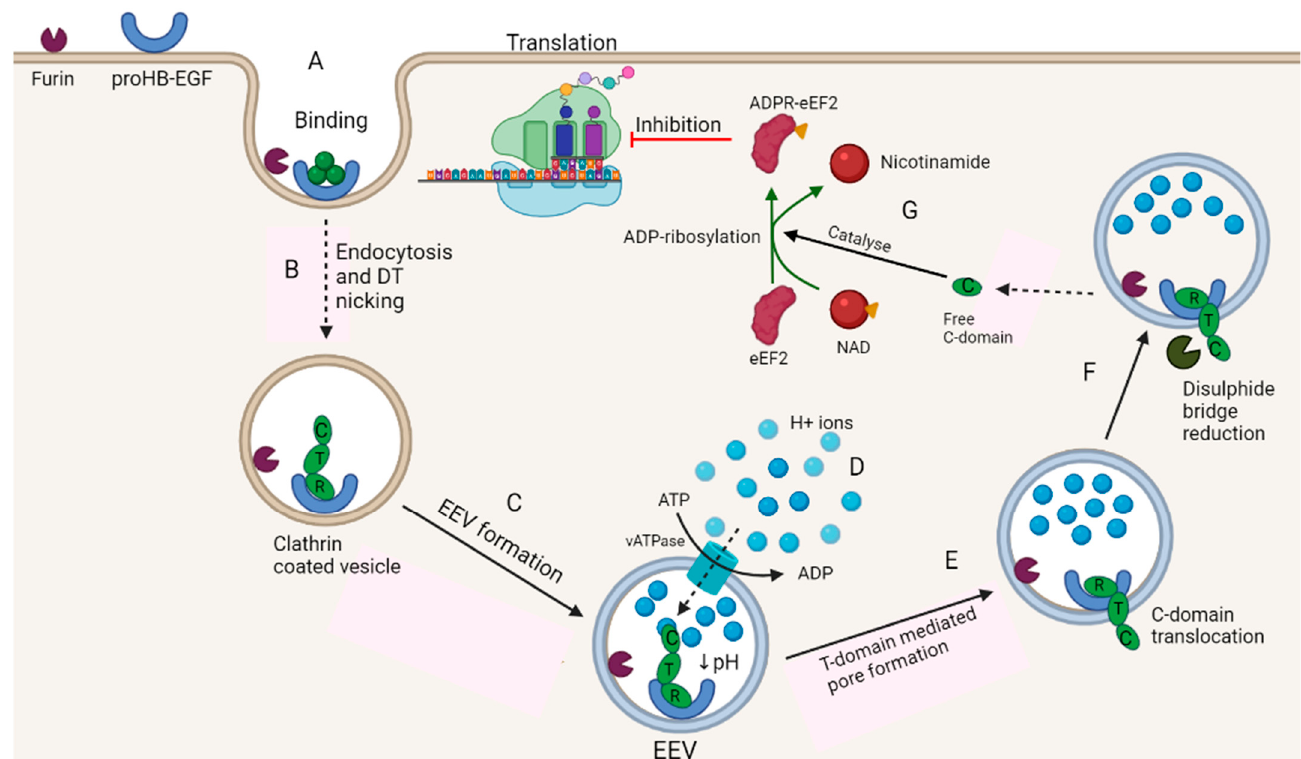
Figure 1. Mode of action of diphtheria toxin (DT). (A) The receptor (R domain) of DT, shown here as green speres, binds to the membrane-anchored precursor of heparin-binding epidermal-like growth factor (proHB-EGF). (B) DT is nicked and the DT-HB-EGF enters a clathrin-coated vesicle through endocytosis. Furin or furin-like proteases converts DT to mature form. (C) An early endosomal vesicle (EEV) is formed by replacing clathrin proteins with the GTPase Arf-1 and coat protein COPI (not shown). (D) EEV is acidified by the transport of protons (H + ) across the membrane, instigated by vacuolar adenosine triphosphatase (vATPase). (E) The T-domain is translocated across the membrane, exposing the C-domain to the cytosol. (F) The disulphide bridge is reduced to liberate the catalytic C-domain. (G) The free C-domain catalyses the ADP-ribosylation of eukaryotic elongation factor 2 (eEF2) to ADPR-eEF2, which inhibits translation. This illustration was made using BioRender (https://biorender.com/, accessed on 12 May 2022).